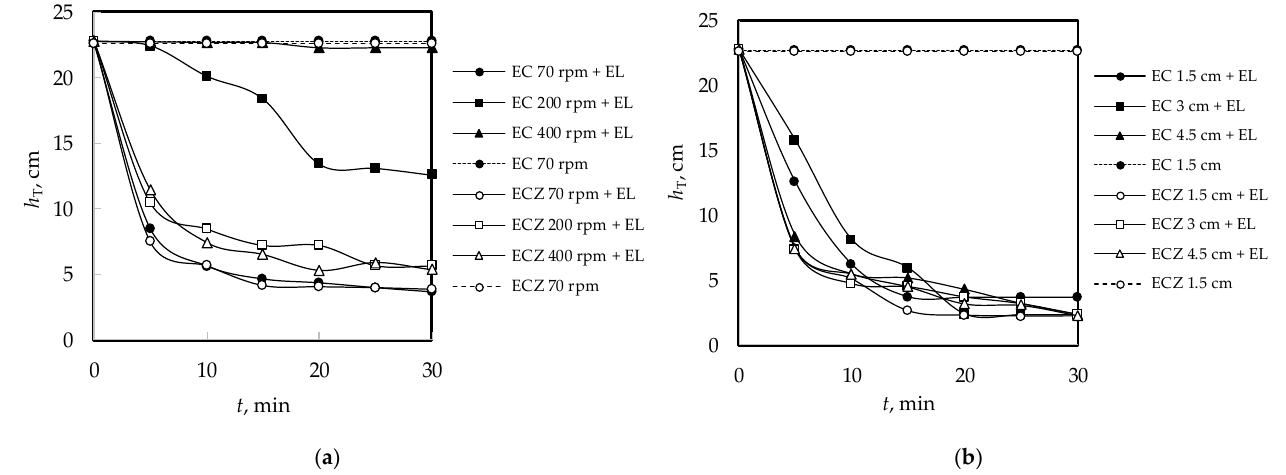
Figure 4. Comparison of sludge settling curve after electrocoagulation process with and without the addition of zeolite, electrolyte at: ( a ) different stirring speeds of 70, 200, and 400 rpm; ( b ) different electrode distances of 1.5, 3, and 4.5 cm.